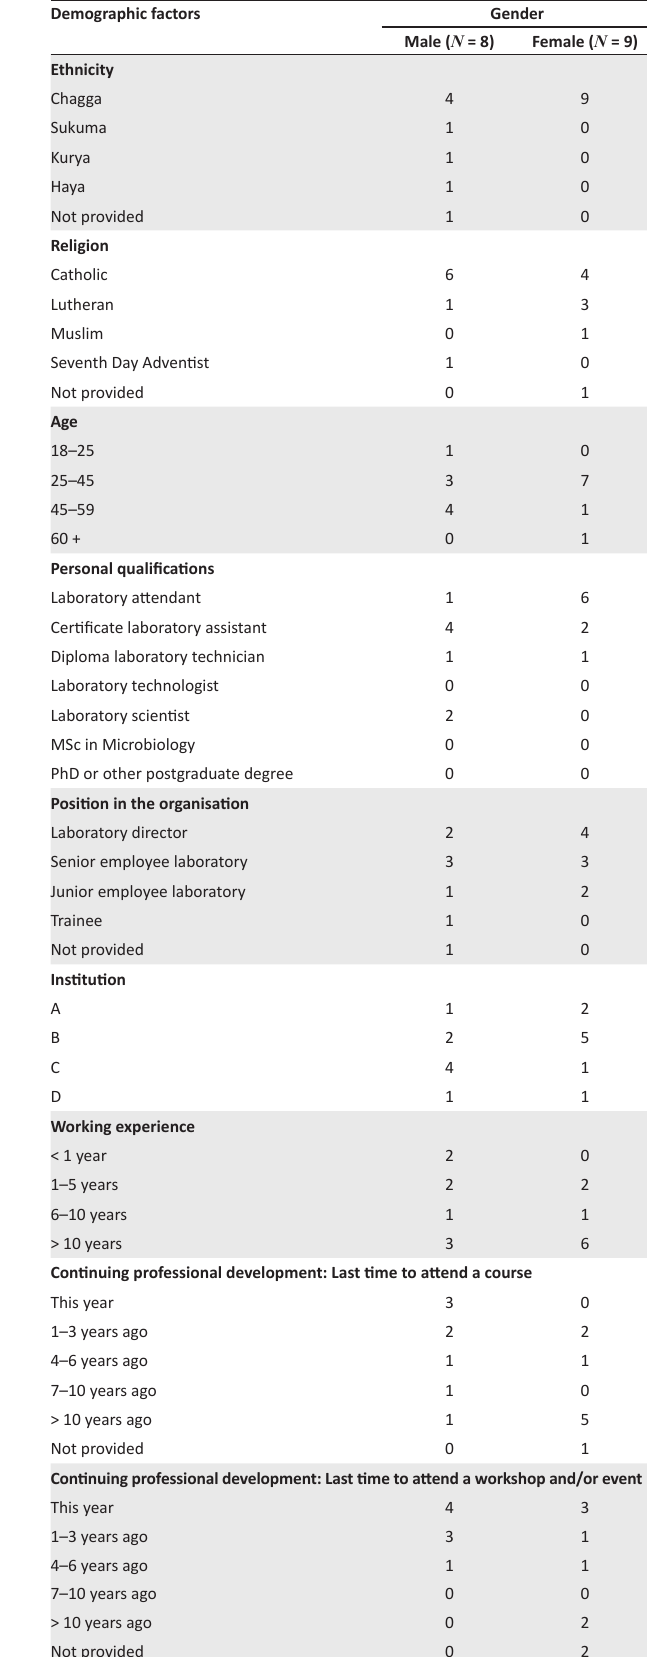
TABLE 2a: The demographic distribution related to the personal identities of the clinicians participating in this field study. Demographic factors